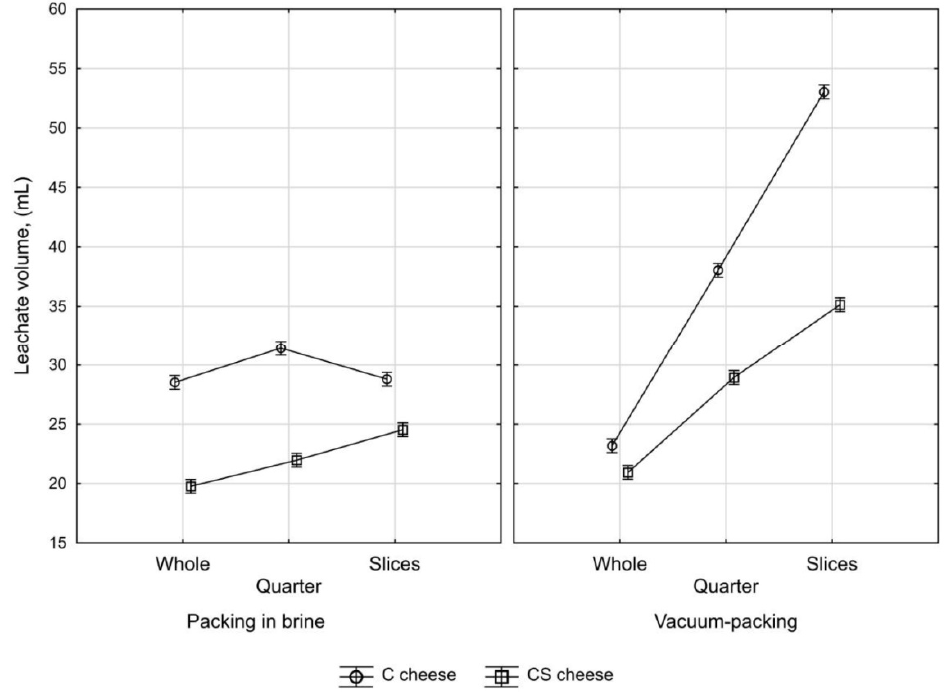
Figure 5. The effect of raw material type, the degree of sample fragmentation and packing method on the average amount of water–fat serum release from fresh pasta filata cheese made from cow’s milk (C cheese) and its mixture with sheep’s milk (CS cheese) within 24 h after its unpacking. Table 5. Three-factorial analysis of variance for the amount of water–fat serum released from fresh pasta filata cheese made from cow’s milk and its mixture with sheep’s milk obtained within 24 h after unpacking.